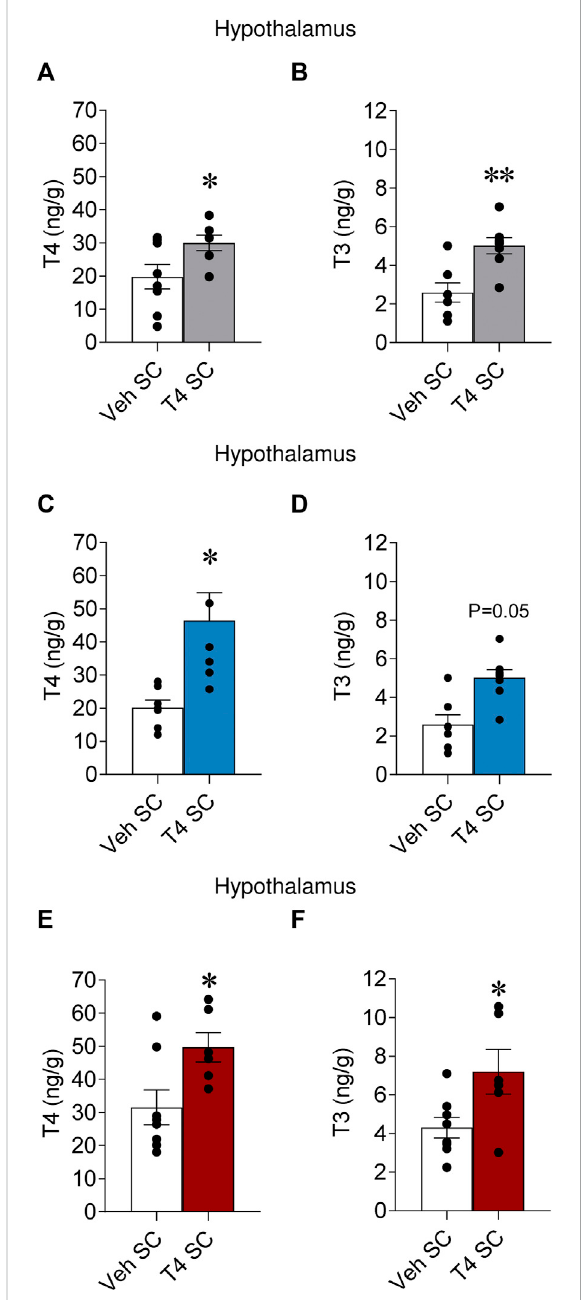
FIGURE 2 Effects of temperature on hypothalamic TH levels in hyperthyroid rats Hypothalamic T4 and T3 levels of euthyroid and hyperthyroid rats housed at 23 ° C (A,B) , 4 ° C (C,D), and 30 ° C (E,F) . Data are represented as MEAN ± SEM. n = 6 – 8 rats/group. Statistical signi fi cance was determined by Student ’ s t -test. * p < 0.05, ** p < 0.01 . Vehicle